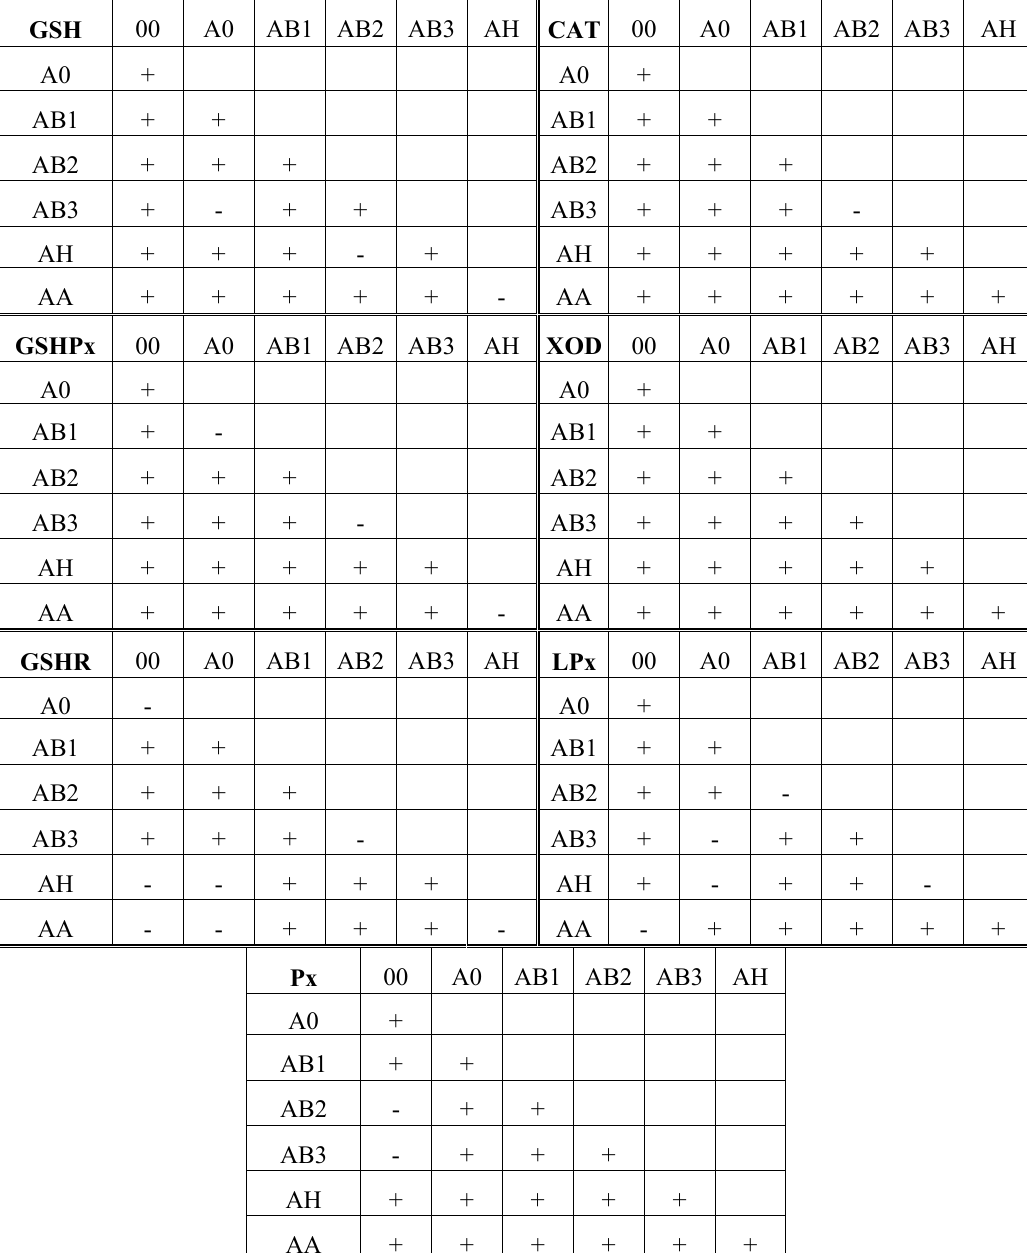
Table 2. ANOVA test for measured biochemical